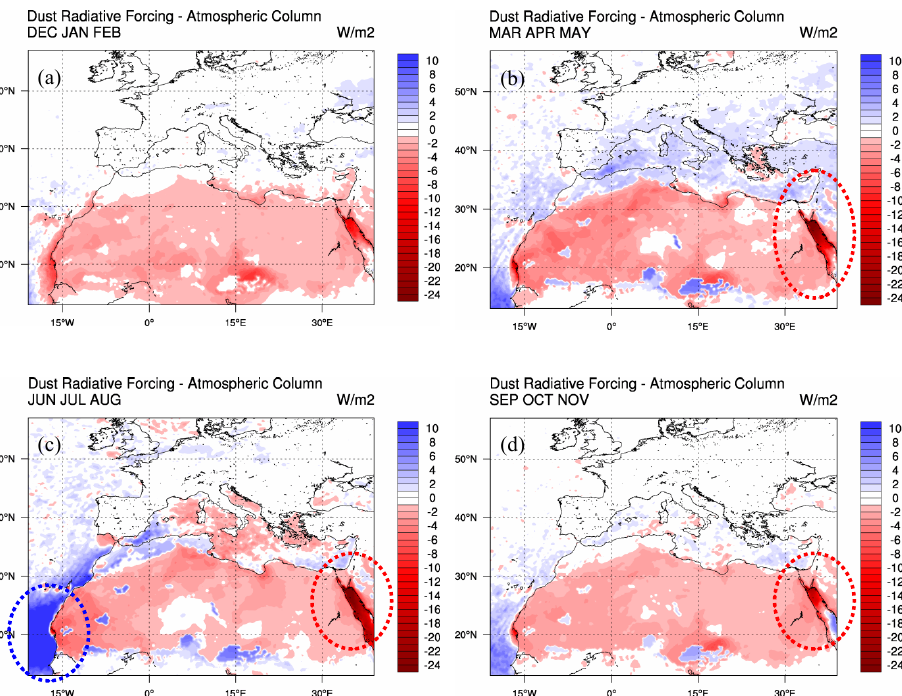
Fig. 13. Differences between the model simulations (WDE – NDE) in the atmospheric absorption at the top of the atmosphere, as averaged during the (a) winter, (b) spring, (c) summer and (d) autumn periods of the 6-year period.